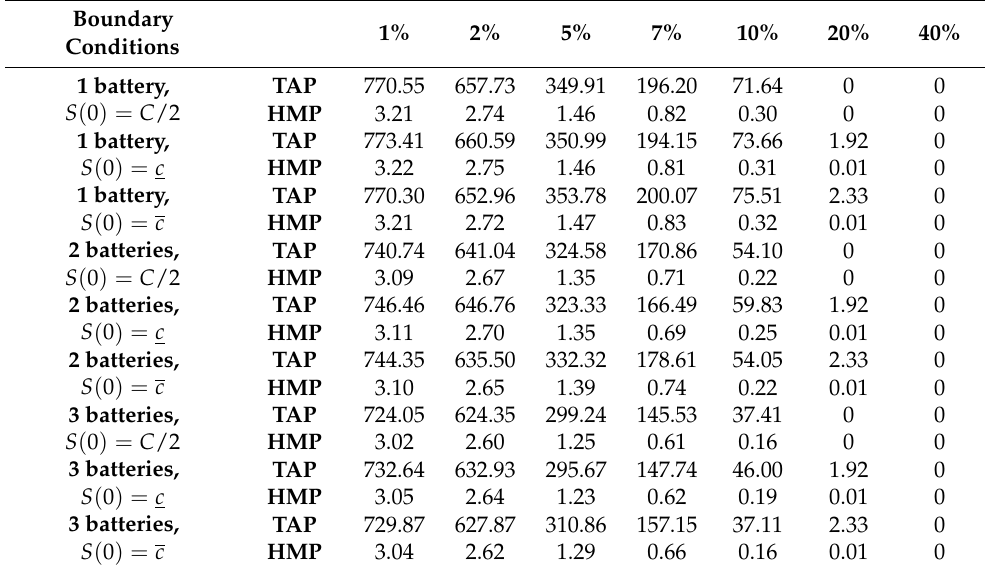
Table 14. Total Amount of Penalty (TAP) and Hourly Mean Penalty (HMP) statistics in EUR referring to the first 10-days data considering the initial state B (0) = 0 and different initial state of charge S (0).